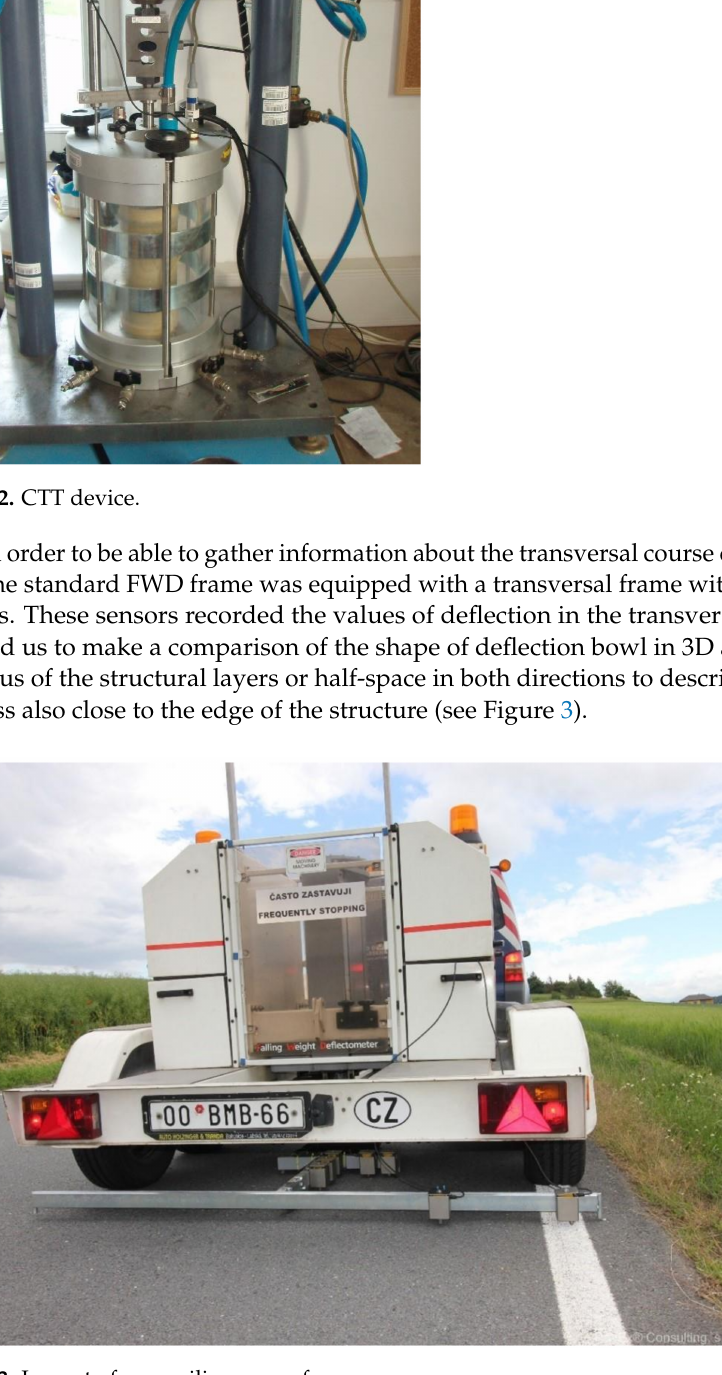
Figure 3. Layout of an auxiliary cross